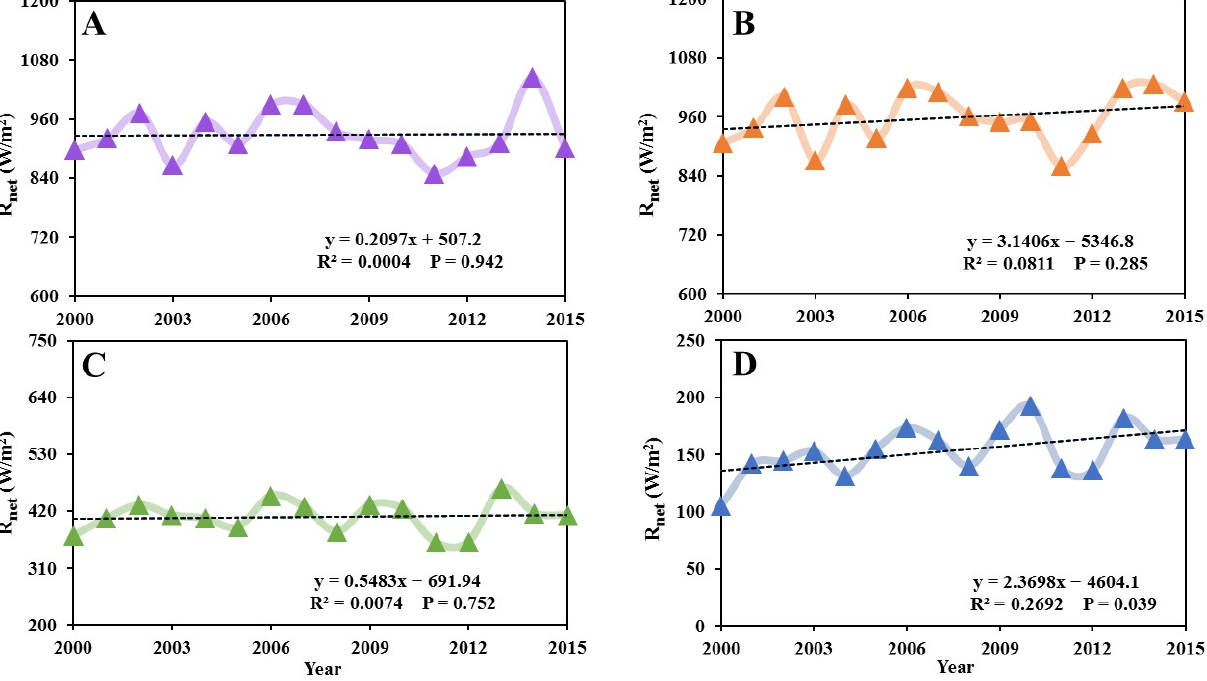
Figure 14. Trend of net radiation from 2000 to 2015 (( A ) Jinan City, ( B ) Zhengzhou City, ( C) Lanzhou City, ( D ) Xining City).